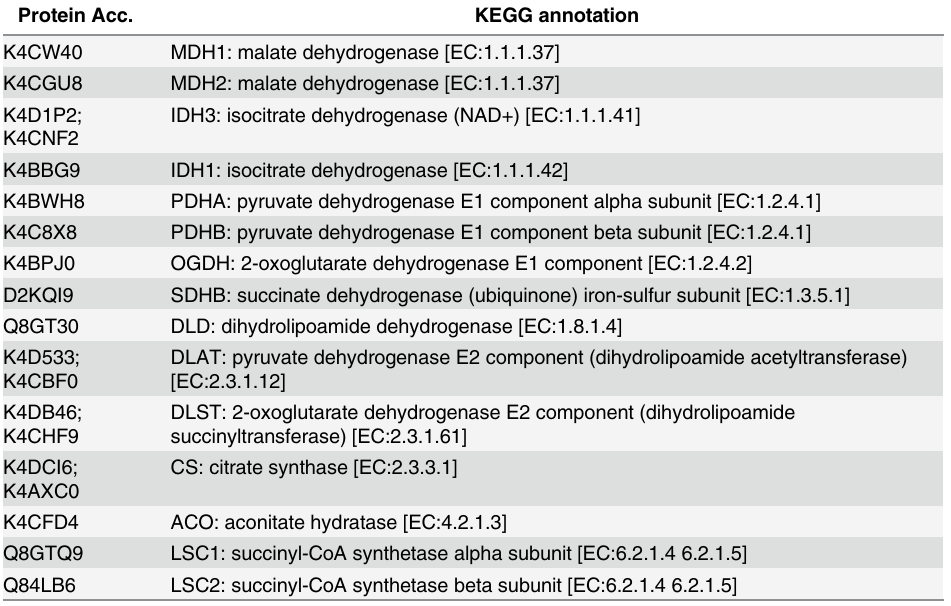
Table 3. Succinylated proteins involved in tricarboxylic acid cycle. Protein Acc.